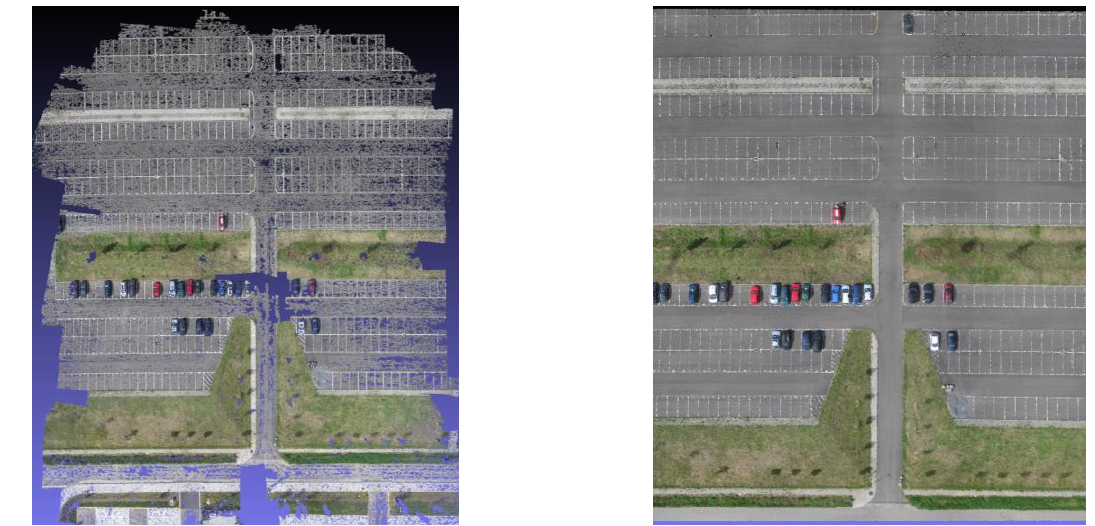
Figure 3. Point cloud computed with PMVS2 (left) and PhotoScan